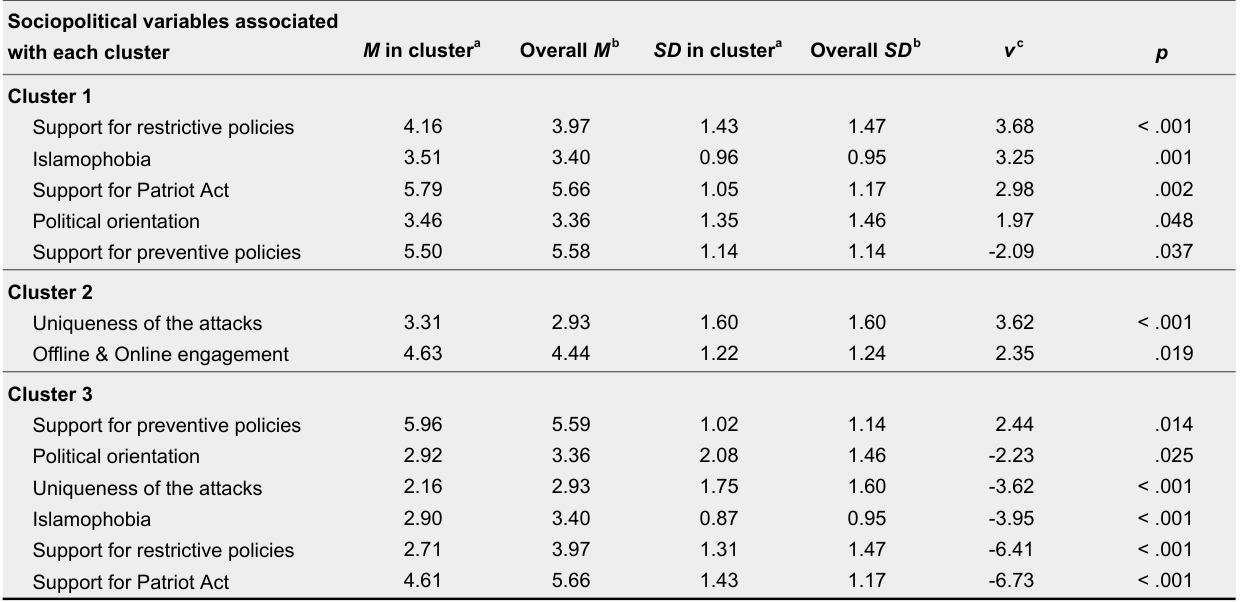
Means and Standard Deviations of the Sociopolitical Variables Most Associated With Each Clusters of Participants Who Mentioned the Analogy With the 11 September 2001